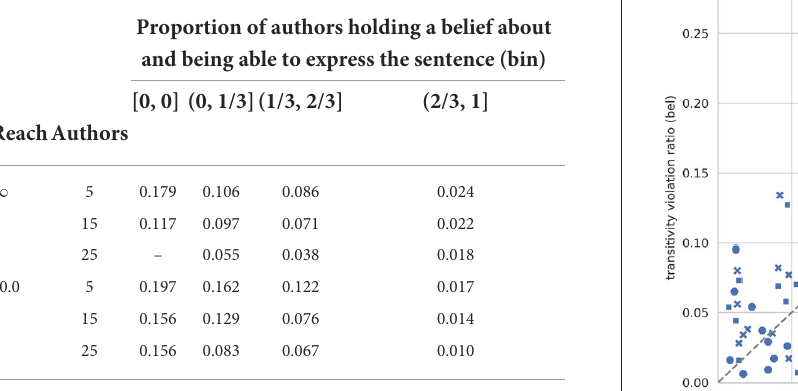
extent does this actually happen in our pre-trained